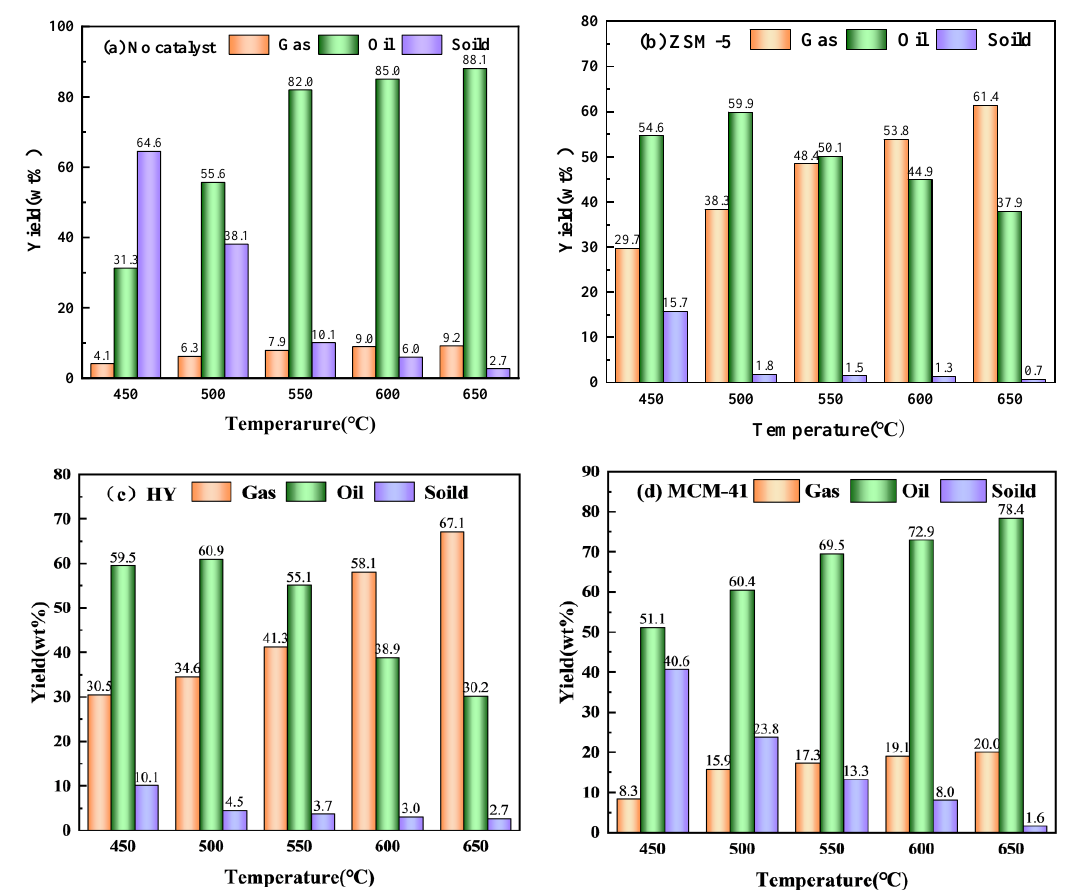
Figure 3. Three-phase yield diagram of LDPE ( a ): no catalyst; ( b ): ZSM-5 catalyst; ( c ): HY catalyst; ( d ): MCM-41 catalyst.